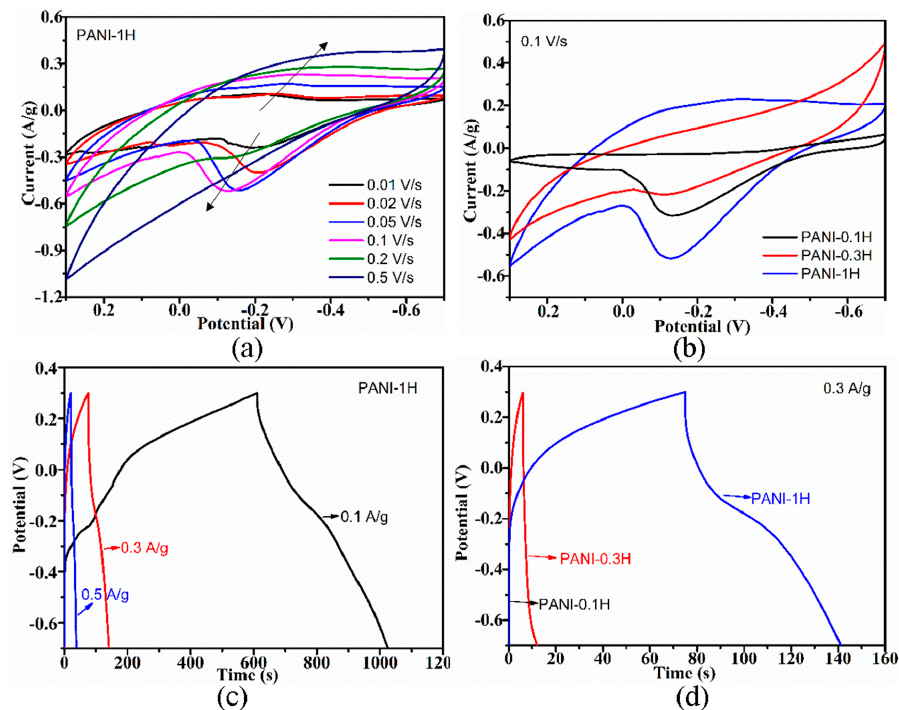
Figure 5. ( a ) CV curves of PANI-1H electrode at di ff erent scan rates. ( b ) CV curves of di ff erent PANI electrodes at the scan rate of 0.1 V / s; ( c ) Charge-discharge plots of PANI-1H electrode at di ff erent current densities. ( d ) Charge-discharge plots of di ff erent PANI electrodes at the current density of 0.3 A / g.